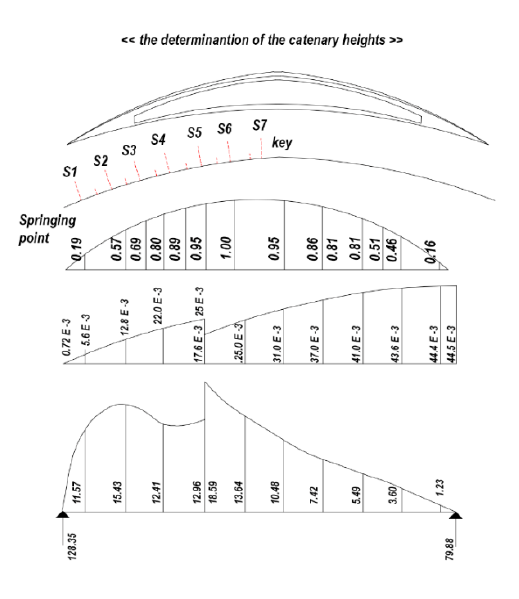
Figure 4: The second stage in Eladio Dieste’s simultaneous form- finding and behavior analysis consists of the translation of the